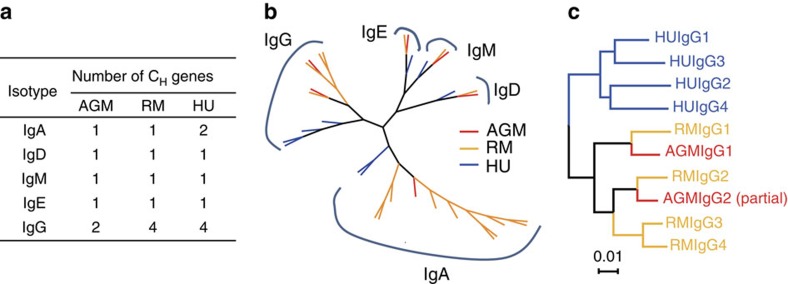
Genetic comparison of immunoglobulin heavy chain constant regions (CH) of AGM, RM and human.(a) Number of immunoglobulin CH isotype genes identified in AGM (n=6), RM (n=8) and human (n=9). (b) Joint radial phylogenic tree of AGM (red lines), RM (orange lines) and human (blue lines) CH genes. Ten RM IgA intra-species heterogenetic alleles were listed in the radial tree. (c) Rectangular phylogenic tree of AGM, RM and human IgG subclass CH genes, demonstrating greater homology of AGM CH genes to that of RM than human.